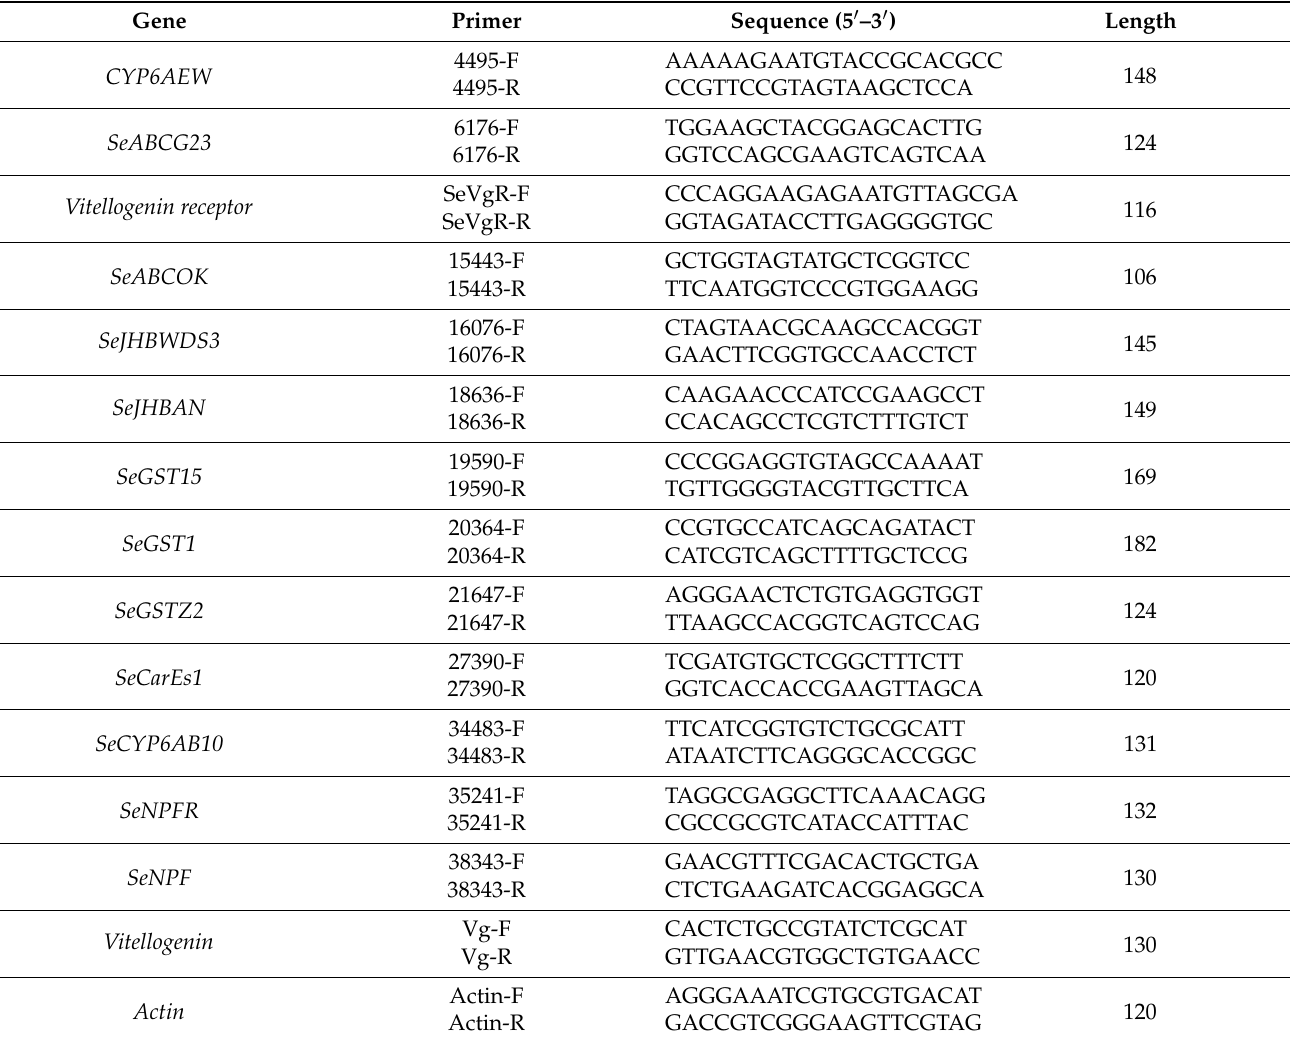
Table 1. Primers of differentially expressed genes for RT-qPCR.